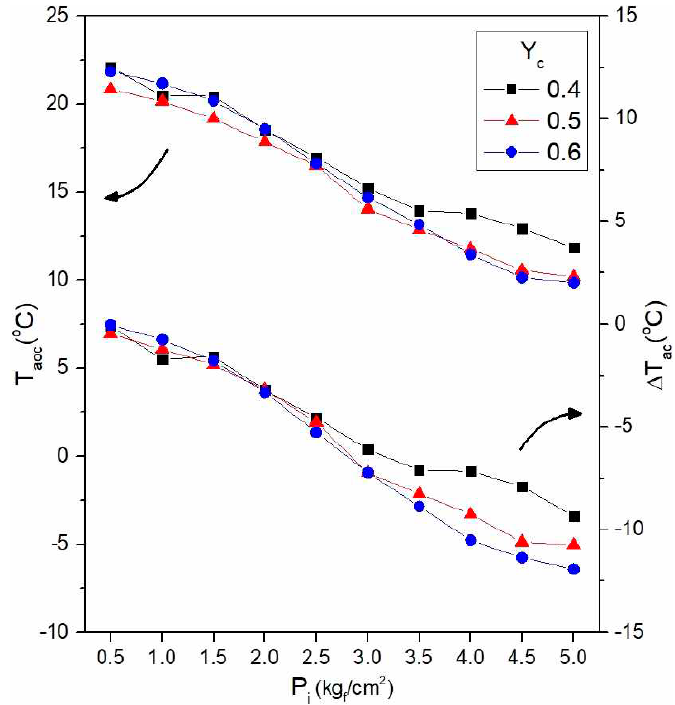
Figure 23. Indirect heat exchange method of ∆ T aoc and ∆ T ac according to pressure.